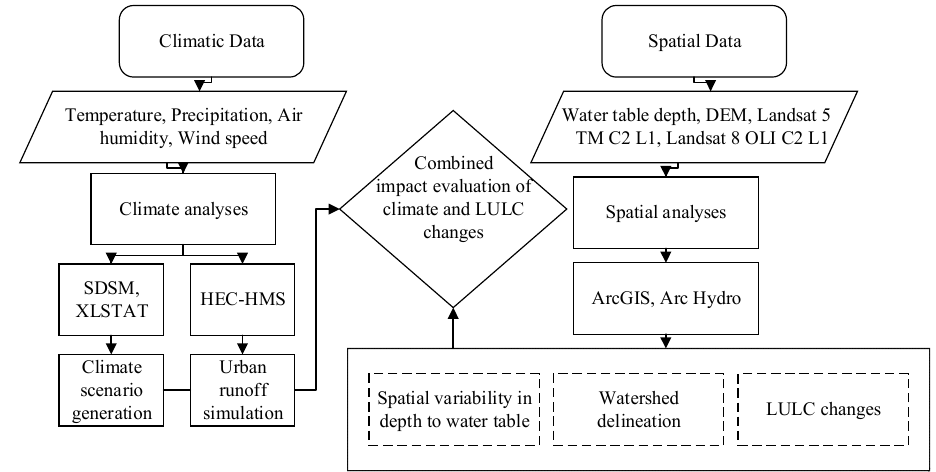
Figure 3. Schematic methodological framework.